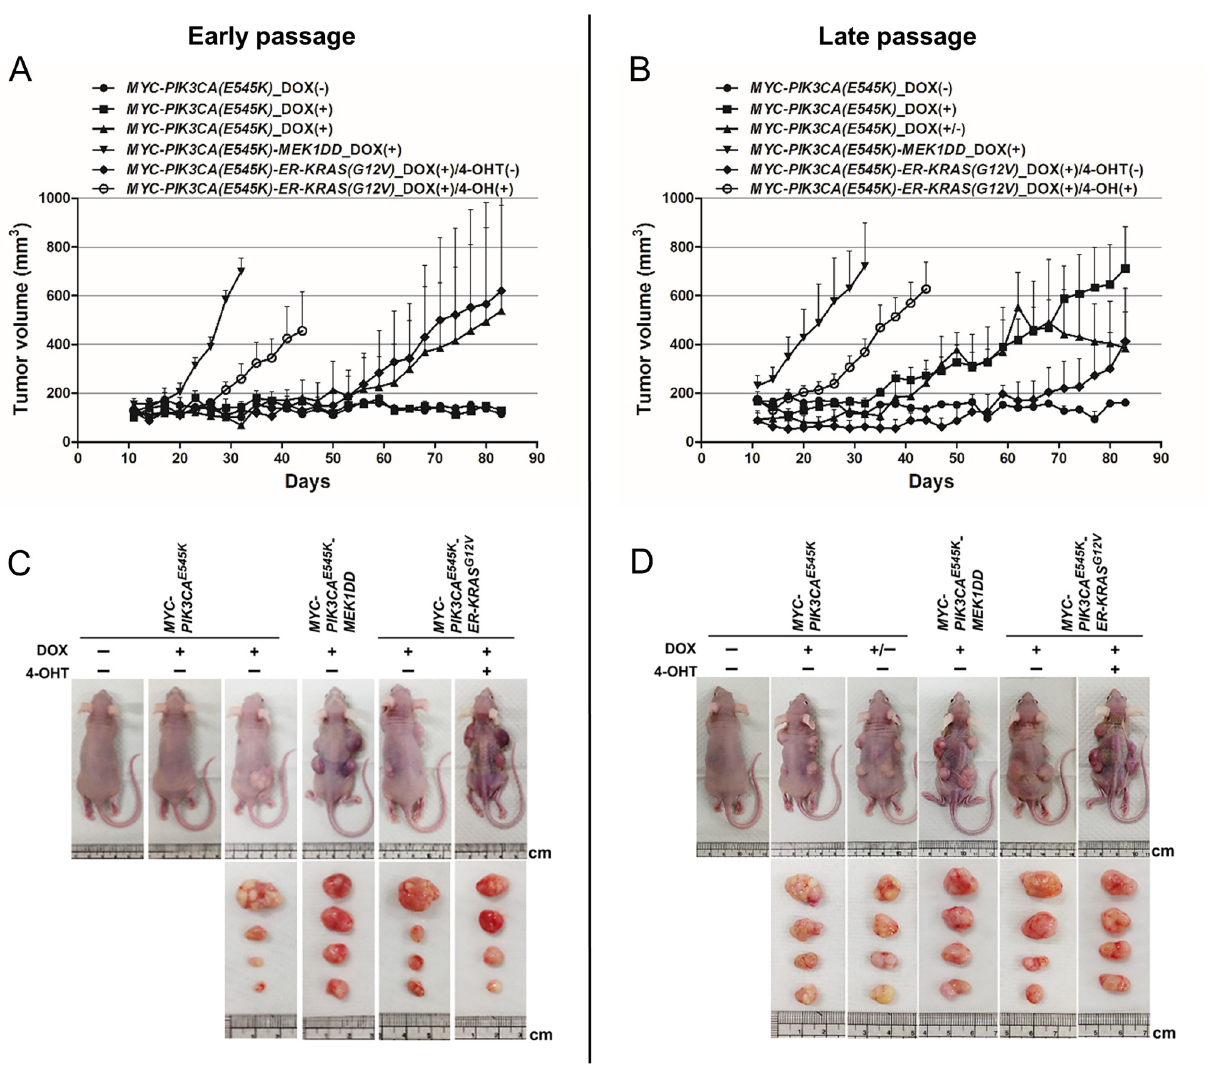
Fig 4. The tumorigenicity of HCK1T/16epi cells expressing oncogenes in nude mice. Tumor-promoting potentials of the MYC , PIK3CA E545K , MEK1DD and ER-KRAS G12V oncogenes were investigated by mouse xenografts. 1x10 6 cells mixed with Matrigel were subcutaneously injected into nude mice. Mice were given 1 mg/ml DOX and/or 0.2 mg/ml 4-OHT, or vehicle. The size of each tumor was measured at the indicated time points. The results from early-passage ( A ) and late-passage cells ( B ) are shown. Transgenic mice were sacrificed after tumor formation then tumor mass was compared for early-passage ( C ) and late-passage ( D ) HCK1T/16epi cells. DOX was removed from drinking water for mice injected with late-passage HCK1T/ HPV16epi cells with MYC and PIK3CA E545K after tumor size reached more than 400 mm 3 .